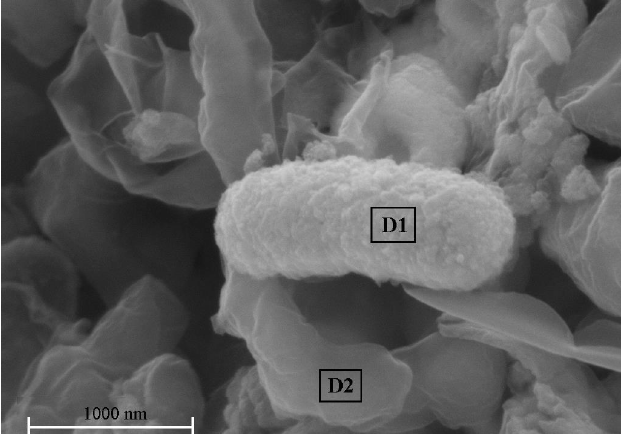
Figure 5. SEM image of sediment from the Clostridium sp. PXL2 cultures. D1 and D2 are typical spot locations for EDS analysis on and around the bacterial cells. Typical images are shown from one of triplicate examinations.